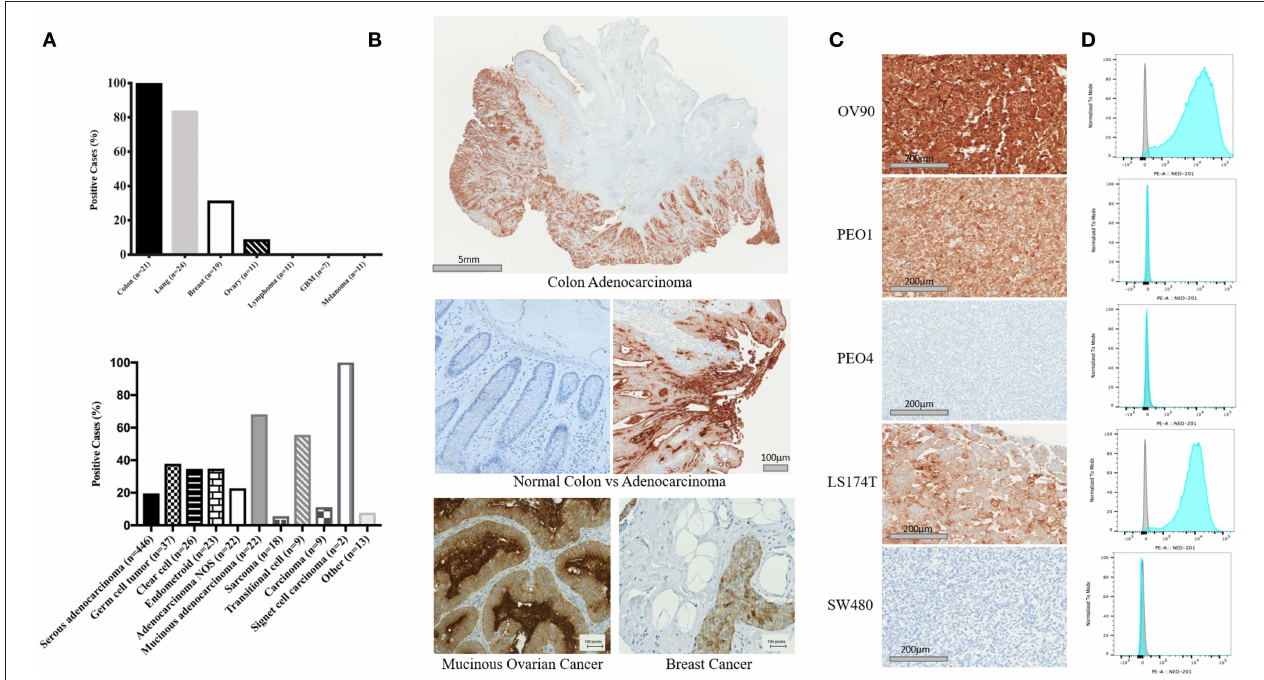
FIGURE 1 | Expression profile of the antigen recognized by NEO-201 in patient tumor tissues and human cancer cell lines. (A,B) NEO-201 binding in colon ( n = 21), lung ( n = 24), breast ( n = 19), and ovarian ( n = 11) cancers, lymphoma ( n = 11), glioblastoma multiforme ( n = 7), and melanoma ( n = 11) was measured by immunohistochemistry (IHC). Additionally, the degree of expression of the antigen recognized by NEO-201 in 627 tissues from more than 10 different ovarian cancer subtypes including serous, germ cell, clear cell, endometroid, mucinous, sarcoma, transitional, and adenocarcinoma NOS, was evaluated by tissue microarray analysis (TMA). Tissues were scored for positive vs. negative expression of the antigen recognized by NEO-201 and for percentage of positive tumor tissue. Those tissues with a complete staining of the membrane in more than 10% of the samples analyzed were given a 2 + score, while those with a complete staining of the membrane in < 10% of the tissue analyzed were given a 1 + . (C) Cell pellet from the ovarian cancer cell lines OV90, PEO1, PEO4, and colorectal cancer cell lines SW480 and LS174T were screened for NEO-201 binding by IHC. (D) NEO-201 binding on cancer cell line model was confirmed by FACS analysis. Cells were incubated with NEO-201 PE-conjugated antibody and then